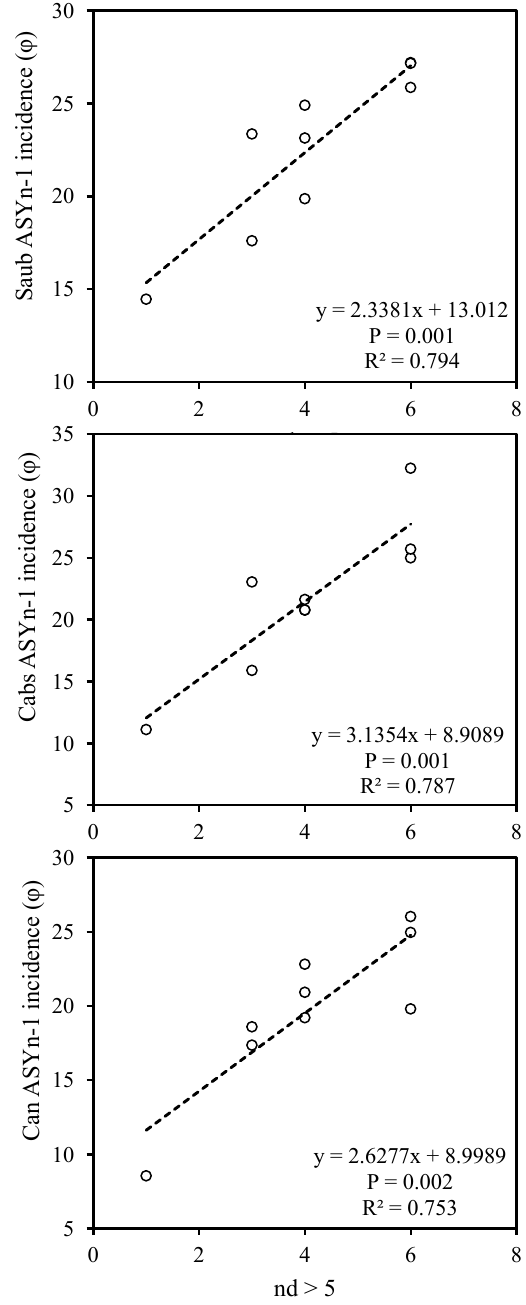
Figure 3. Regressions between arcsin-square root trans- formed (degrees ϕ) annual incidence of Sauvignon blanc (Saub), Cabernet sauvignon (Cabs) and Cannonau (Can) plants showing GLSD foliar symptoms in year n but symp- tomless in year n-1 (ASY n-1) and number of days with rain greater than 5 mm (nd > 5) in the 30 days after stabilization of average temperature around 10